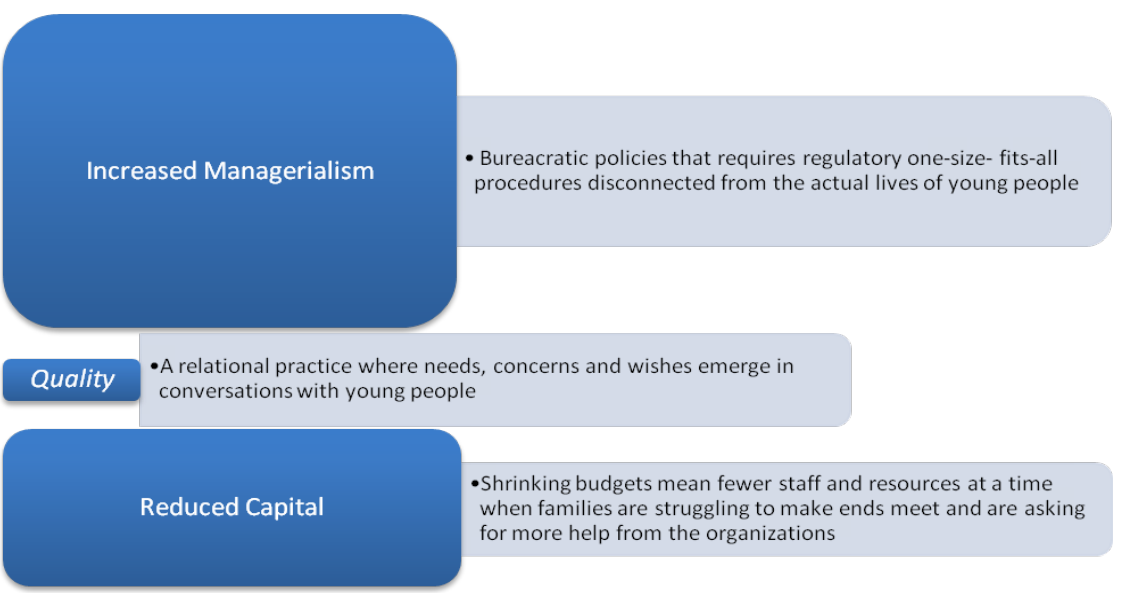
The Accordion Effect: Squeezing out